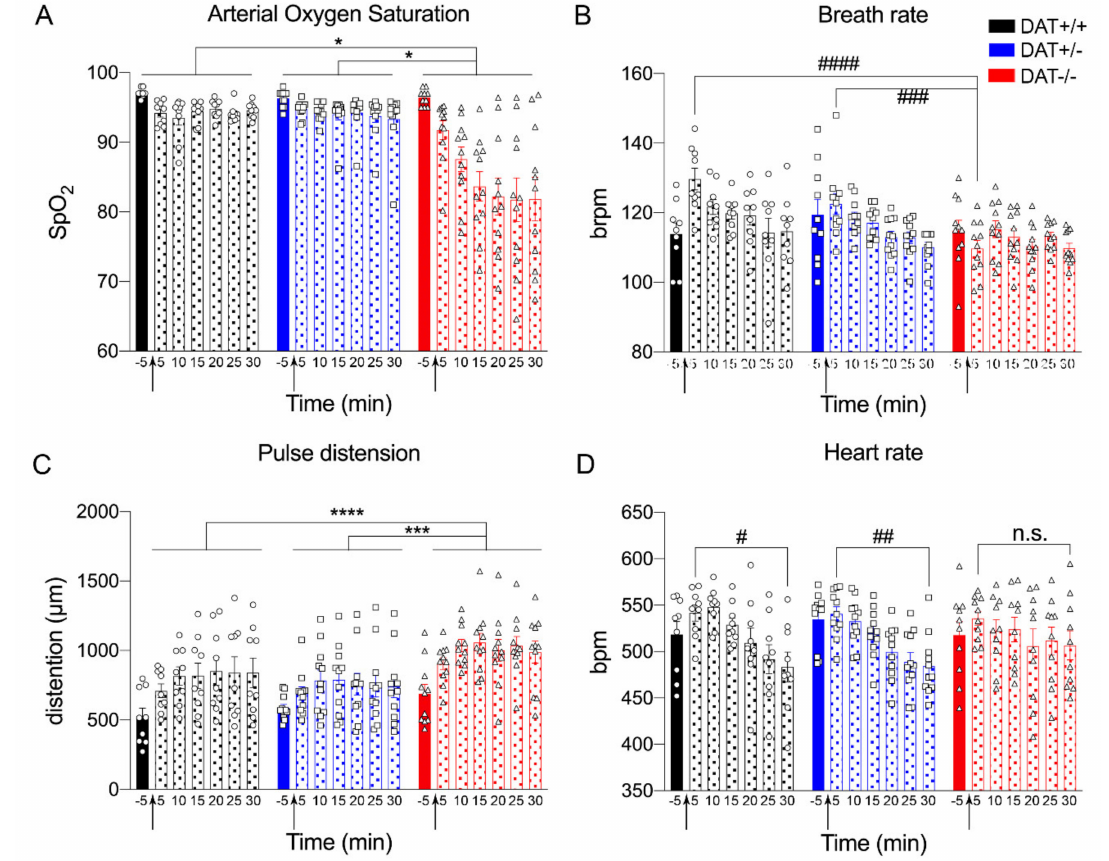
Figure 4. Autonomic response in DAT-KO rats exposed to restraint stress. ( A ) Restraint stress severely reduced arterial oxygen saturation (SpO 2 ) in DAT - / - rats. ( B ) Breath rate (breaths per minute - brpm). ( C ) Pulse distension ( µ m) was also a ff ected by restraint stress in DAT- / - rats. ( D ) Heart rate (beats per minute – bpm). Arrows indicate start of the restraint. ‘-5 (cid:48) indicates measure of parameters 5 min prior the initiation of restraint (basal). The data were expressed as mean ± SEM ( n = 9–11), * p < 0.05, ** p < 0.01, *** p < 0.001, **** p < 0.0001 compared to DAT +/+ controls; # p < 0.05, ## p < 0.01, ### p < 0.001, #### p < 0.0001 between time points